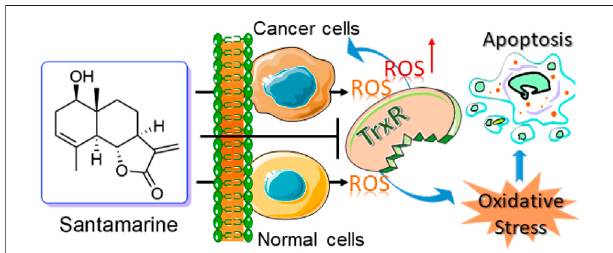
FIGURE 7 | Revealing a new action mechanism of santamarine for targetingTrxRtoinduceoxidativestress-mediatedapoptosistoselectivelyact on tumor